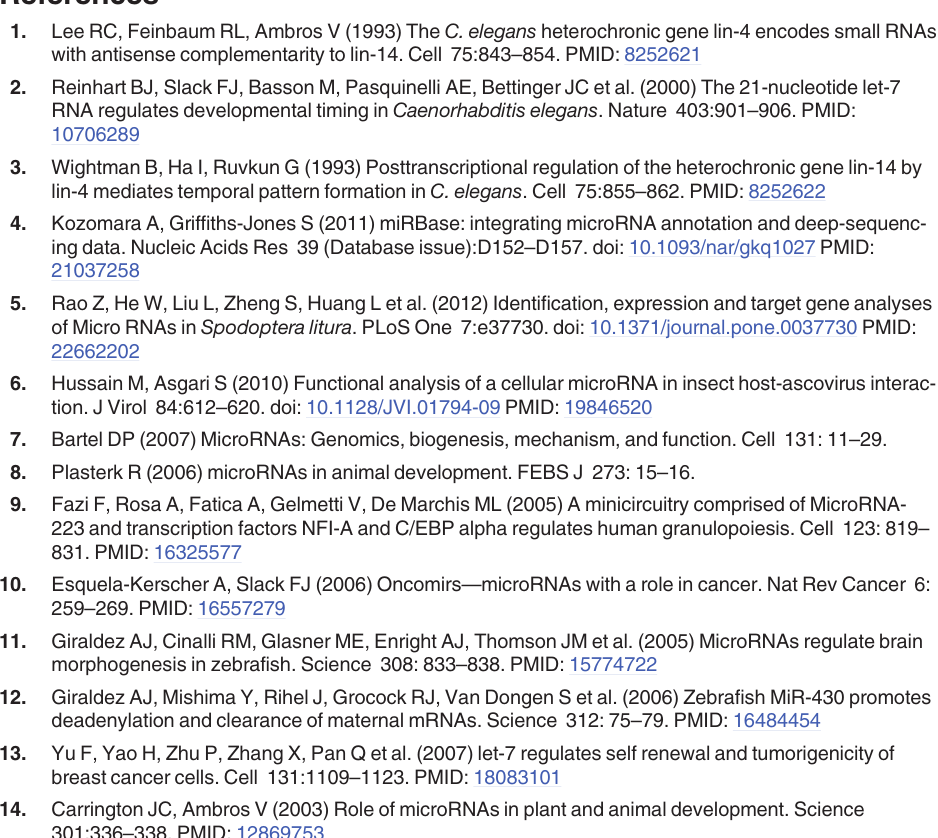
S1 Table. Information on all the known and novel miRNAs identified in the present study from Sf21 cells. S2 Table. Information on the abundance of novel miRNAs present in the clusters identified in the present study on different genome scaffolds of Sf21